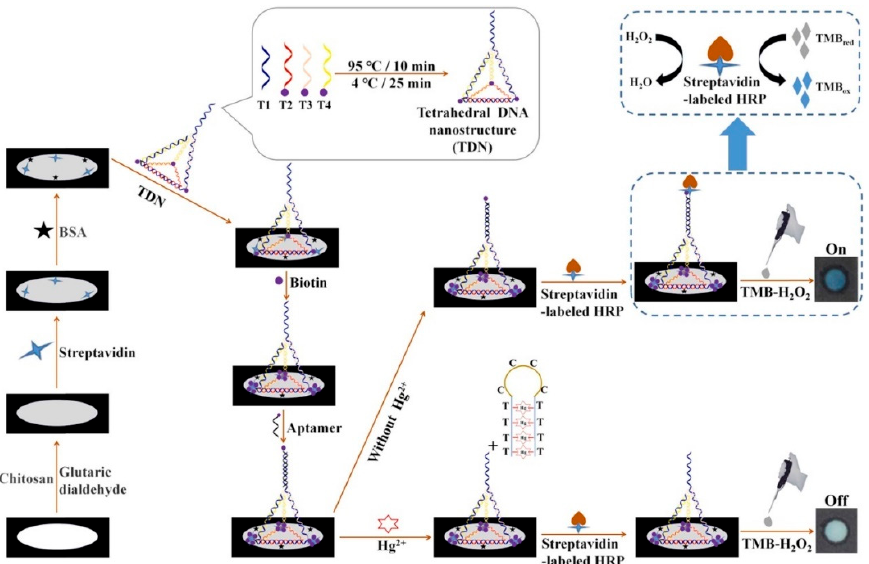
Figure 7. Schematic diagram of the fabrication procedures of DNA tetrahedron functionalized paper- based colorimetric sensor for Hg 2+ detection. Reprinted with permission from Ref. [68]. Copyright 2022